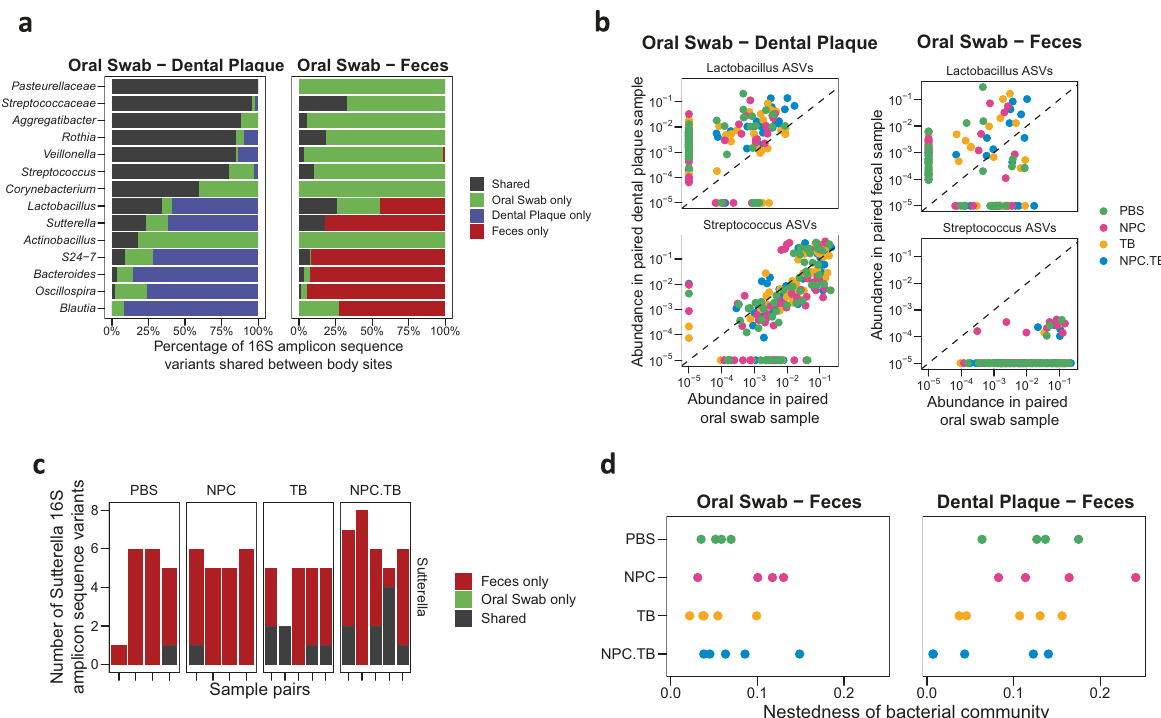
Fig. 4 Impact of repurposed drug on bacteria shared between body sites in the host. a Common bacterial ASV between dental plaque and oral swab samples, and between oral swab and fecal samples. b Streptococcus and Lactobacillus ASVs shared between oral swab – dental plaque and oral swab-fecal paired samples. c Number of Sutterella ASVs shared in oral-fecal samples. Each column is a sample facet by treatment groups. d Nestedness, or shared bacterial community, found in each treatment group when compared between oral and gut sites. Each point corresponded to a sample. ASV amplicon sequence